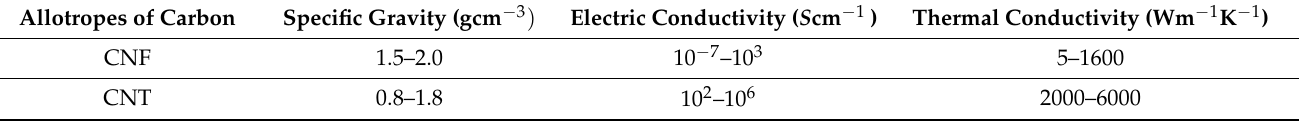
Figure 18. ( a ) Permittivity (ε΄) and ( b ) electromagnetic interference shielding effectiveness (EMI-SE) Table 3. Comparison of carbon nanotube (CNT) and CNF [12]. Allotropes of